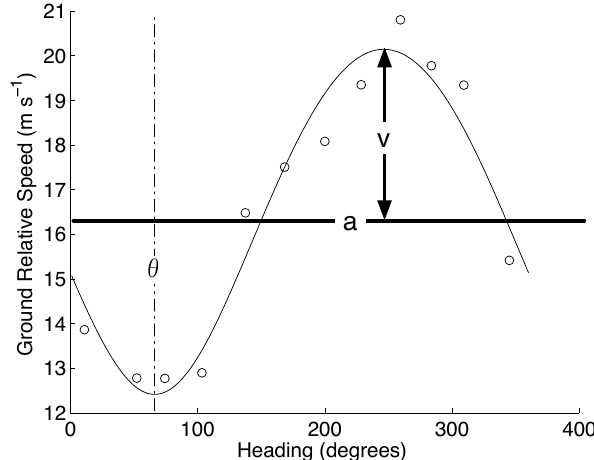
Fig. 3. Example fitting of the equation in the BCF. This corresponds to the circle between 207 m and 218 m above ground level (AGL). The curve indicates the best fit of Eq. (1) and the circles represent the data from the GPS unit. Airspeed ( a ) is marked by the solid line, wind speed ( v ) is noted by the dotted arrows, and wind direction ( θ ) is shown by the dash-dotted line. Fig. 2. A trace of a flight path on 17 November 2011. The shading indicates the SMARTSonde’s ground relative speed (m s − 1 ). On this day, the wind direction was northerly, becoming more easterly with height. The winds affect on the aircraft’s speed can be seen, as the aircraft moved faster with a tailwind and slower with a headwind.